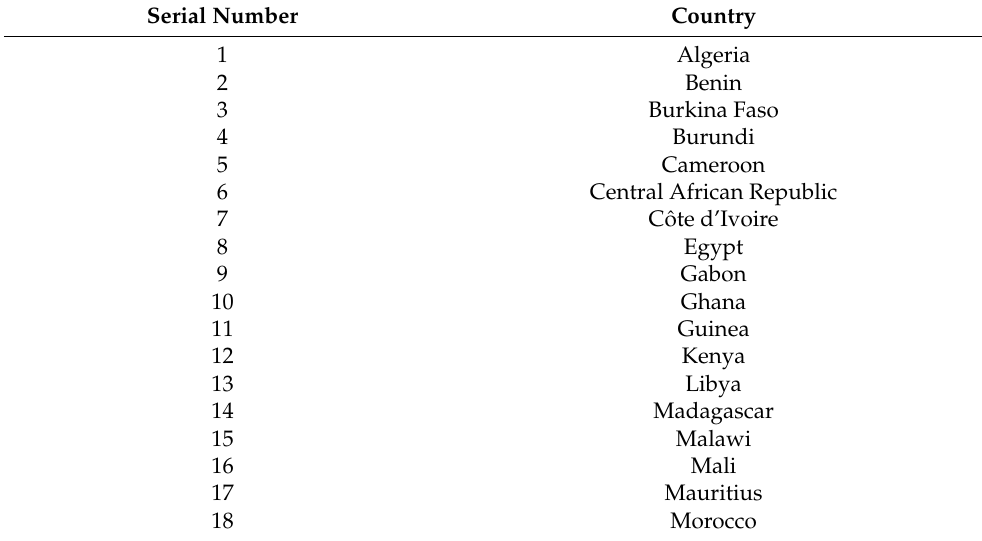
Table 1. List of countries